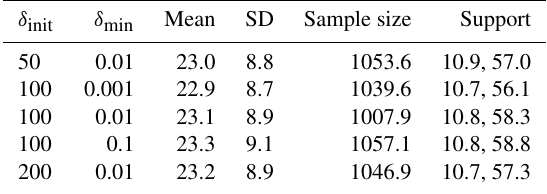
Table A1. Distribution sensitivity to various parameters of random positioning. All quantities, except the sample size, are expressed in metres. The statistics are averages computed over 50 realisations. The support is truncated to the 0.5th and 99.5th percentiles. δ init δ min Sample